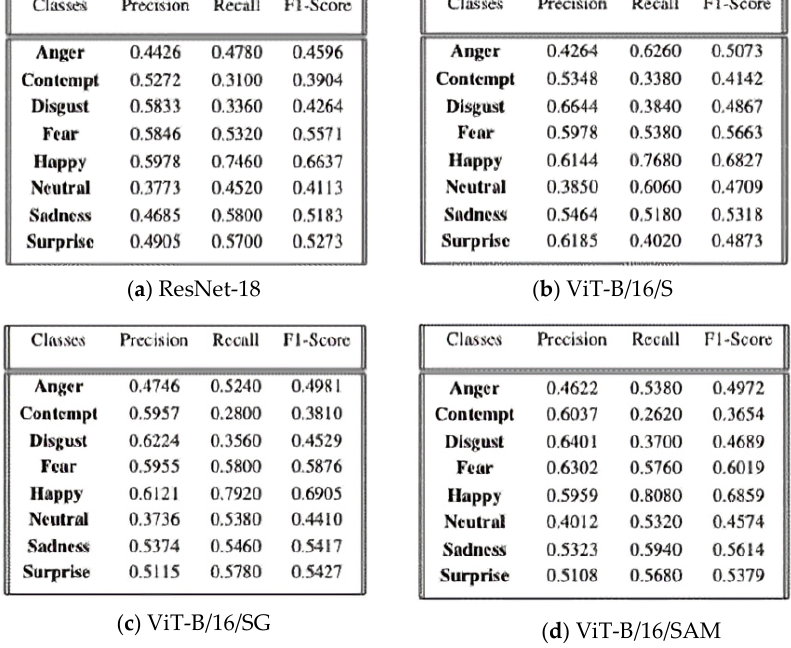
Figure 12. Tables of precision, recall, and F1-score for each class.